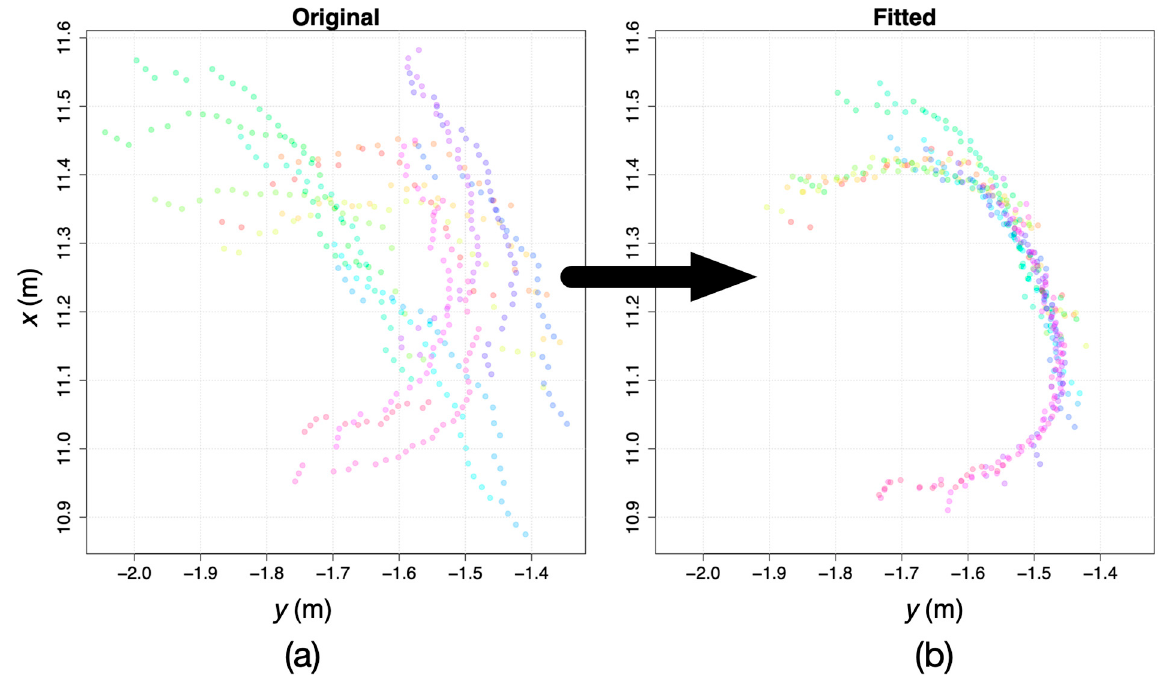
Figure 3. An example cluster illustrating the action of the scan-matching algorithm (minimization of length of minimal spanning tree—see main text). ( a ) The input to the algorithm comprised 16 horizontal LiDAR scans (each color designates one scan) for cluster 22 (see Figure 2), transformed and collated using the SLAM trajectory for the UAV; ( b ) the output from the algorithm comprised the same 16 scans but with their x and y positions adjusted.